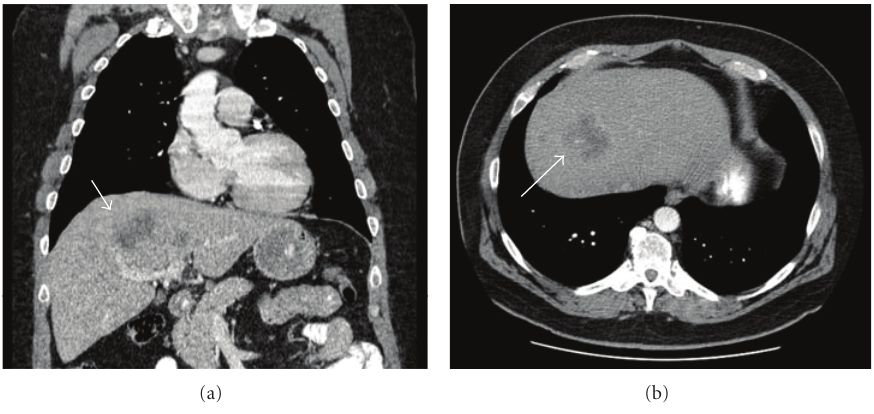
Figure 1: Abdominal CT scan showing hypodense lesion near the dome of the right hepatic lobe (arrow).